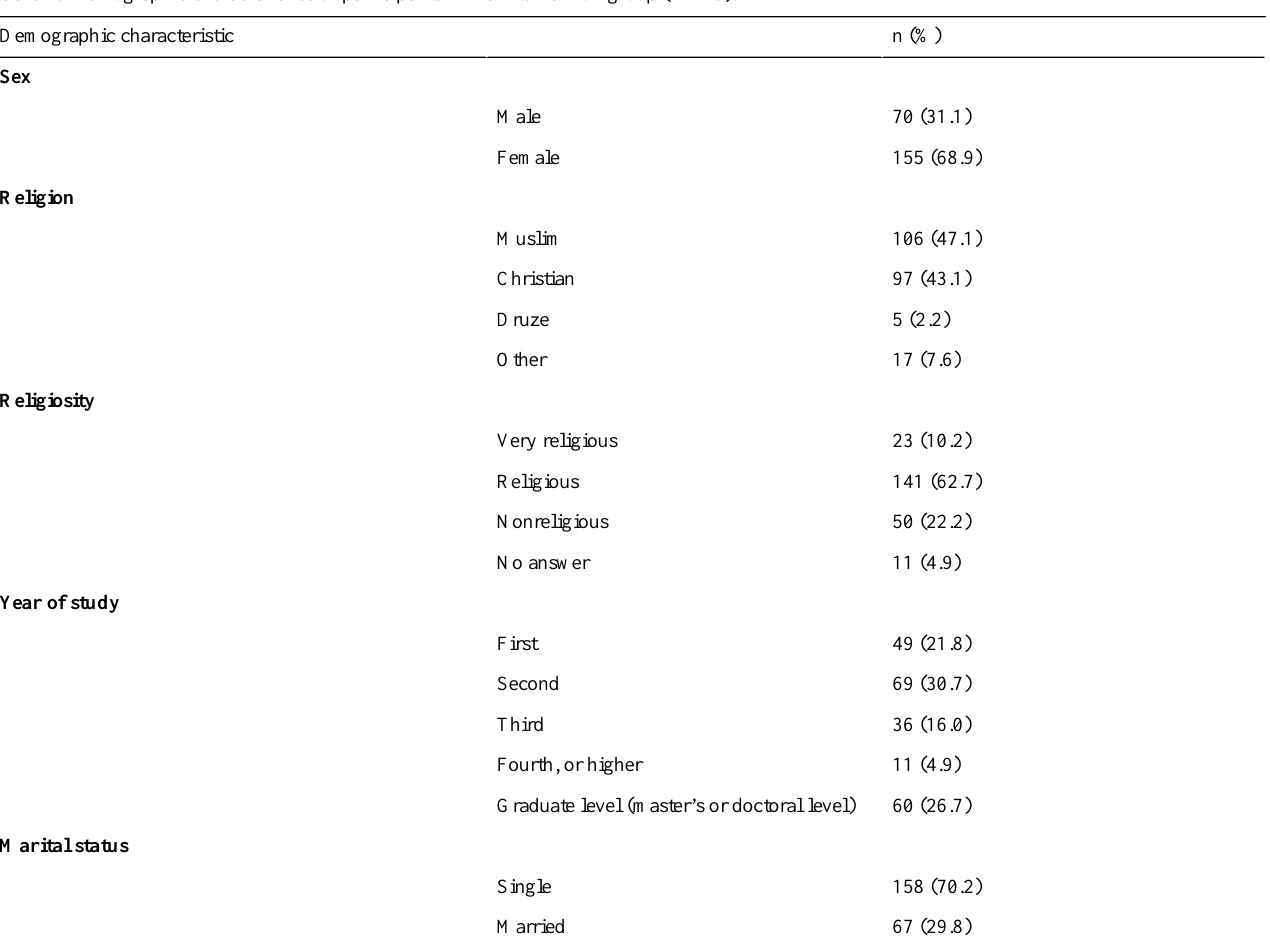
Table 1. Demographic characteristics of participants in the intervention group